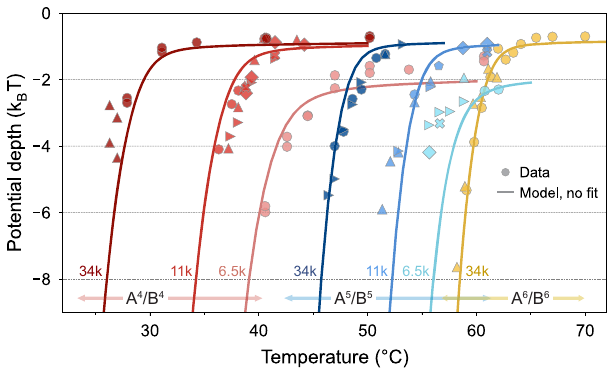
Fig. 3 Control of melting properties with hybridizing pair number and chain length. Potential well depths measured for different experimental systems: PEO brushes with M w of 6.5 k, 11 k, and 34 k, and colloid/glass surfaces attached with 4 (-GCAG/-CTGC), 5 (-GACGC/-GCGTC) or 6 (-TGCGGT/-ACCGCA) DNA complementary bases. The different symbols correspond to different particles. The model predictions (with no additional fi tting) with photon shot noise are overlaid. The particles with 34 k and six sticky bases correspond to that in Fig. 1e, f, and Fig. 2. At high temperatures, all particles experience a constant ~1 – 2 k B T well depth from van der Waals